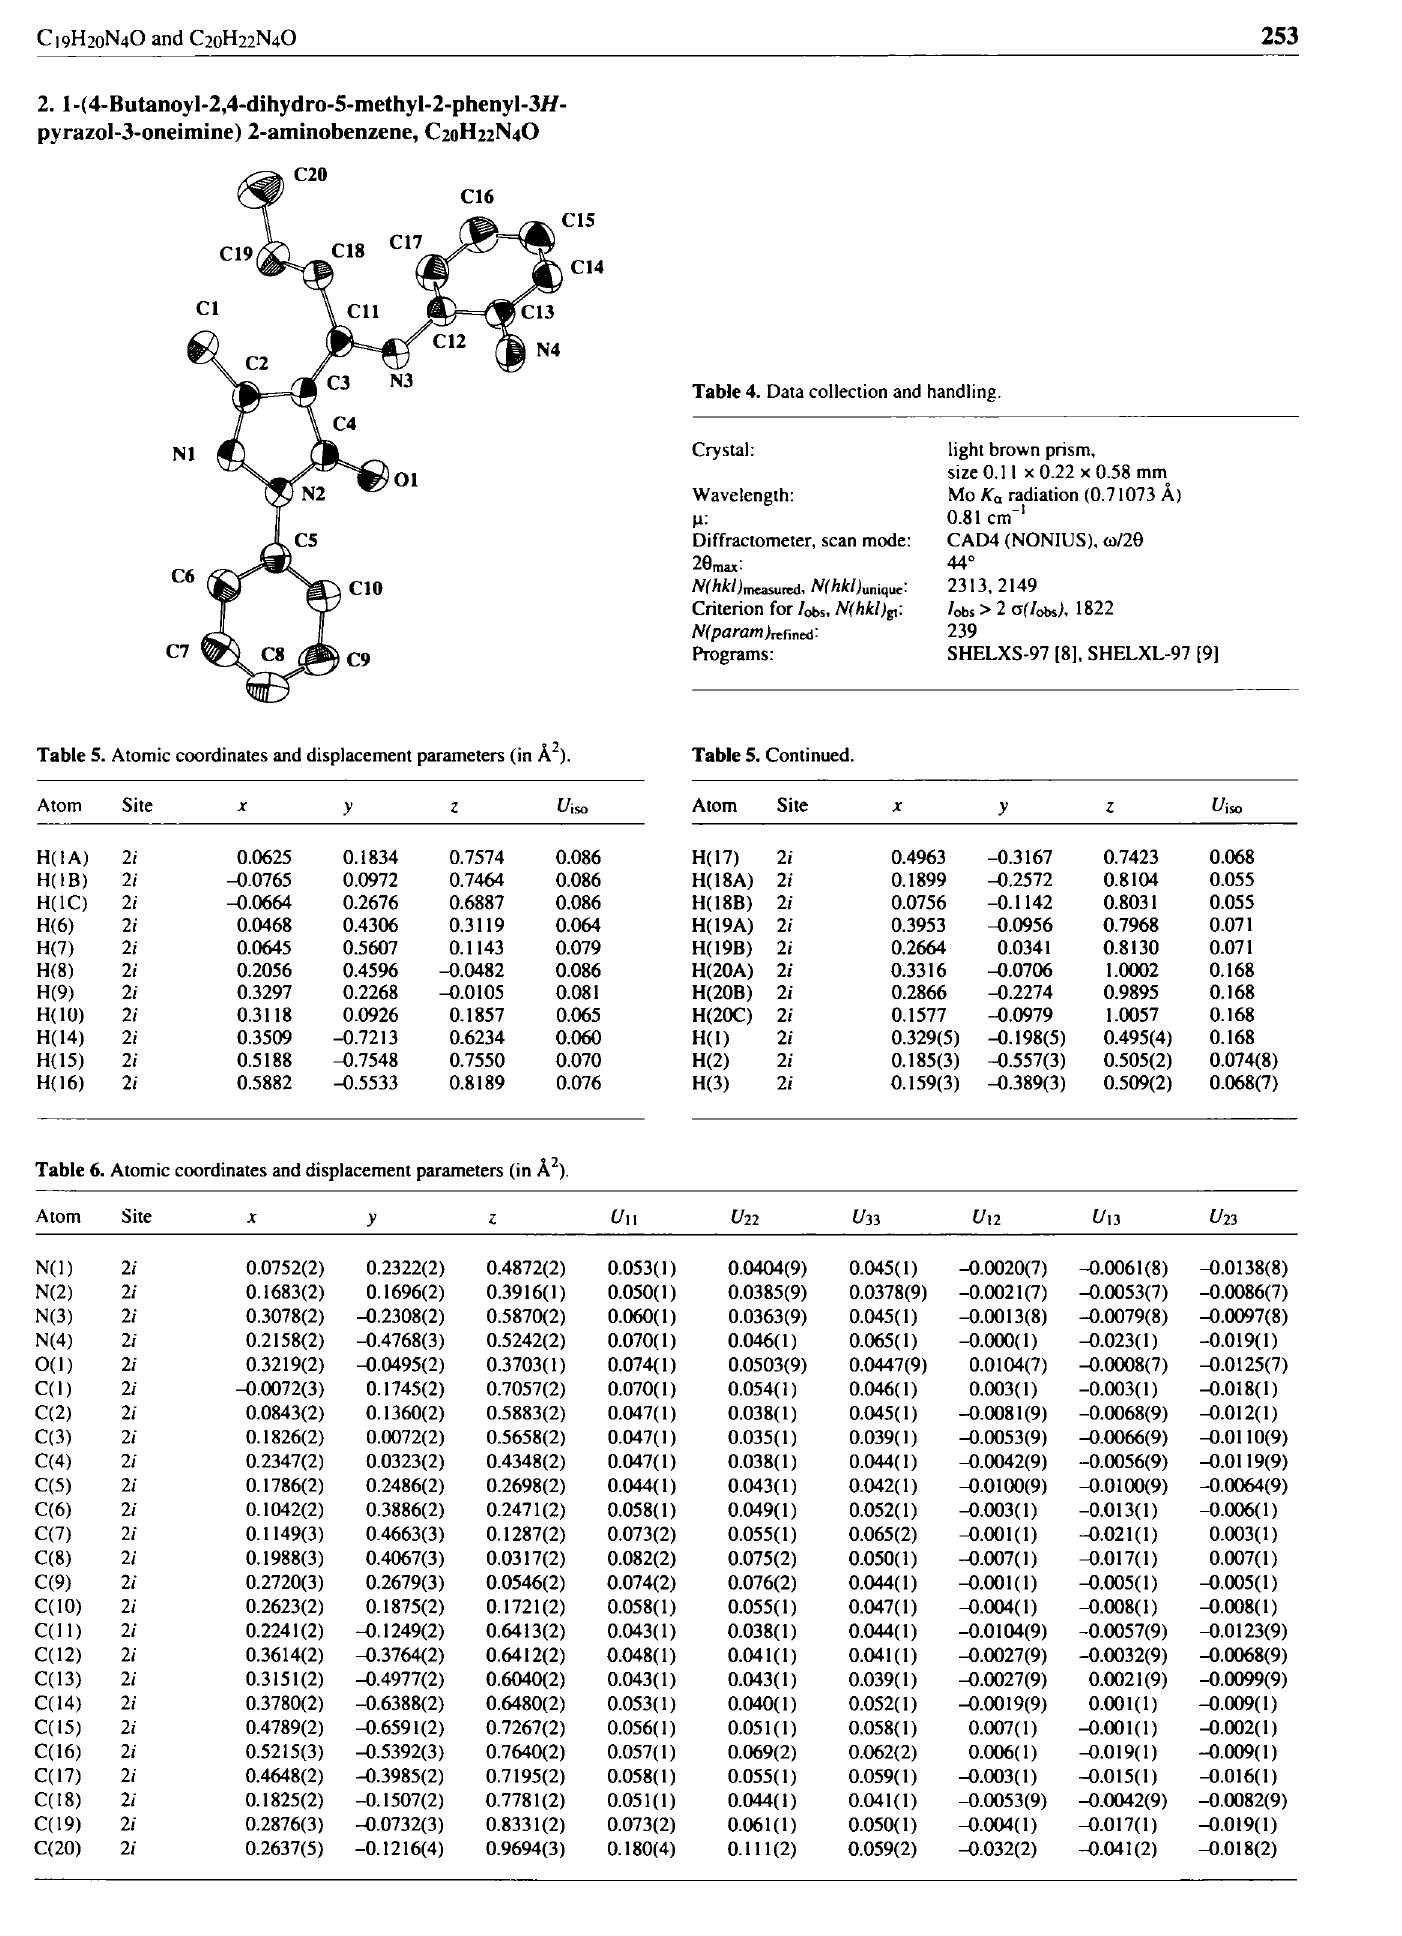
Table 5. Atomic coordinates and displacement parameters (in A 2 ). Table 5. Continued.